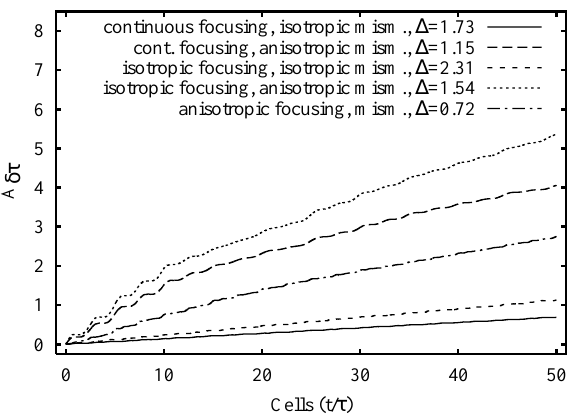
FIG. 6. Temperature anisotropy coefficients A dt for 5000 simulation particles versus the number of cells obtained by 3D simulations of different focusing systems and matching conditions at s 0 (cid:1) 60 ± , s (cid:1) 15 ± per cell, for a normalized correlation time dt (cid:1) t (cid:1) 0.455 .